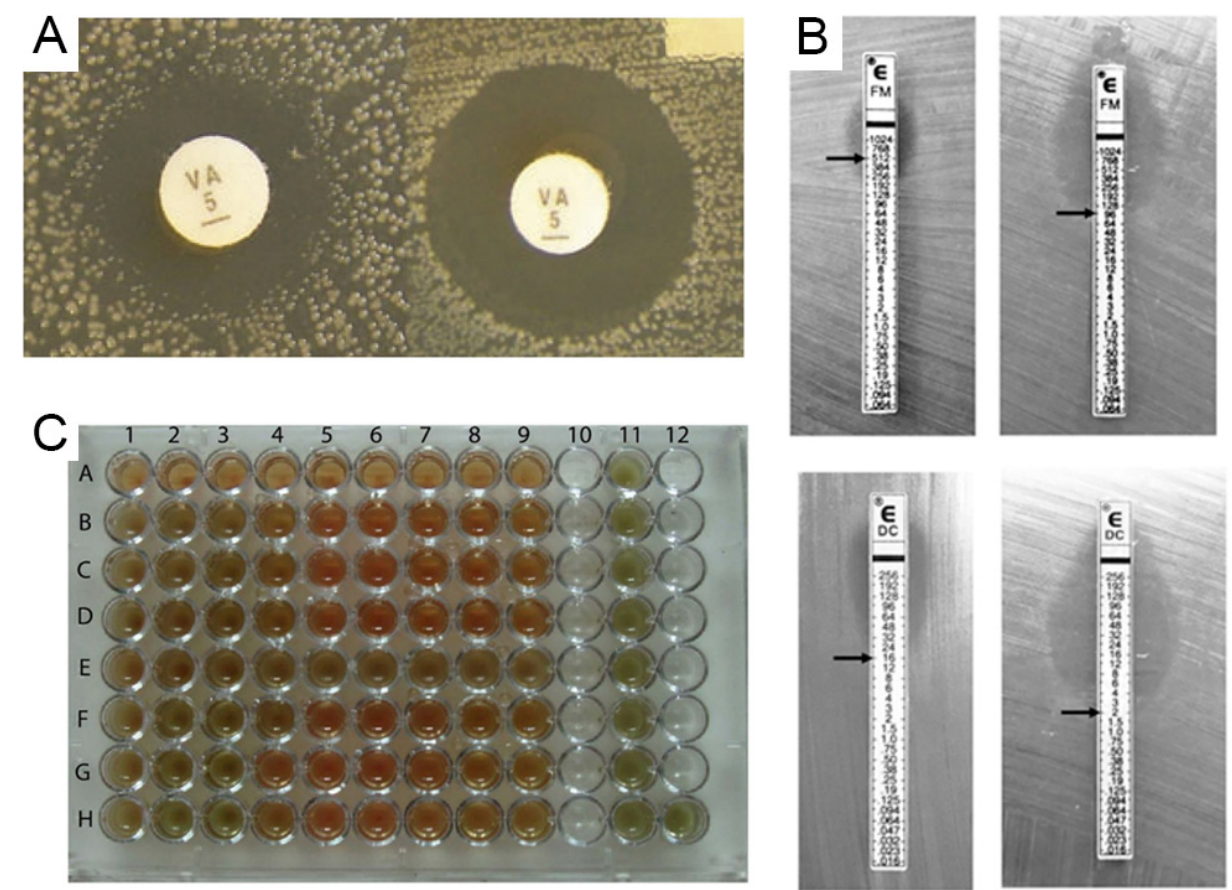
Figure 2. Representation of various conventional antibiotic susceptibility testing methods. ( A ) Disk diffusion, demonstrating inhibition zones, adapted from [21]. ( B ) Example of a GRD Etest used to detect vancomycin-intermediate Staphylococcus aureus , adapted from [22], ( C ) Illustration of an example of the 96-well micro plate’s broth microdilution method for two Streptococcus pneumoniae strains’ vancomycin assays, reproduced from Ataee and co-workers [23]. In that plate, the 9 wells in row A serve as a negative control, while rows B, C, and D for strain one and rows F, G, and H for strain two contain vancomycin concentrations ranging from 0.5 to 128 g/well for the MIC determination. Nine wells in the E row and 11 columns are designated as positive controls.